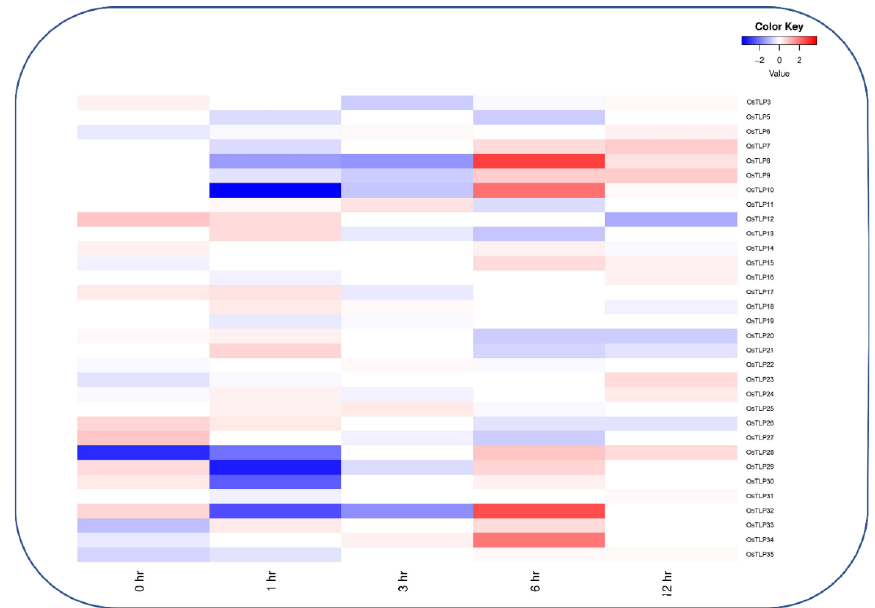
Figure 8. Heatmap of OsTLP genes representation under jasmonic acid. The log2 transformation method normalized and converted the RPKM values displayed.